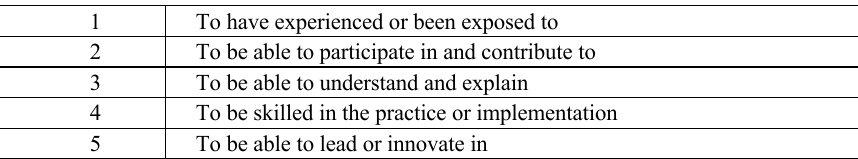
Table 2. Expected Level of Proficiency